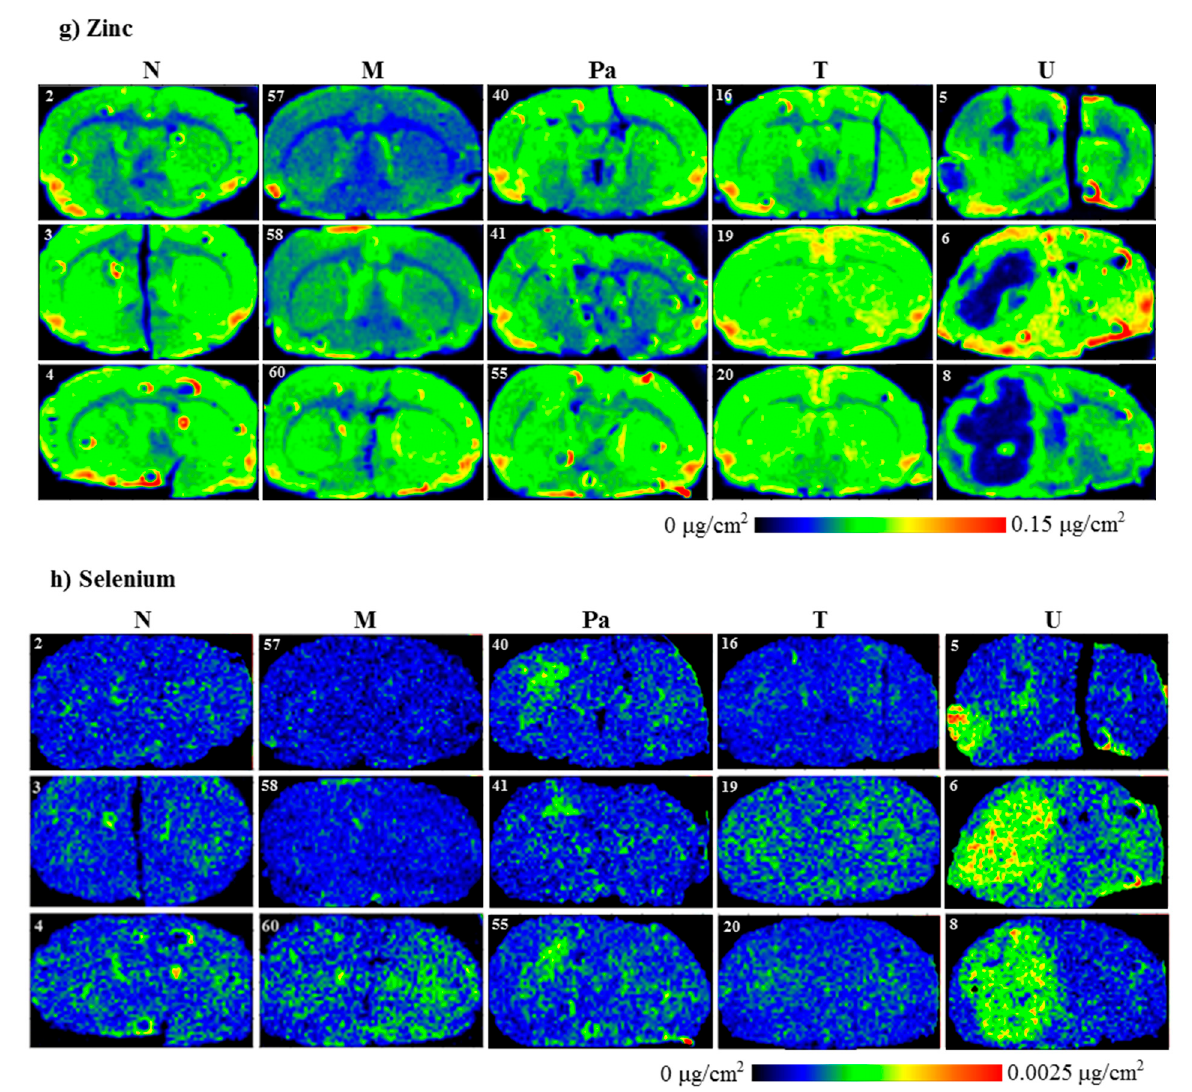
Figure 3. Topographic elemental maps of brain slices taken from the rats of all experimental groups for: ( a ) phosphorus, ( b ) sulfur, ( c ) potassium, ( d ) calcium, ( e ) iron, ( f ) copper, ( g ) zinc and ( h ) selenium. Color scales express areal densities of elements in µ g/cm 2 . In the case of Ca, large differences in areal densities were observed between groups N, M, Pa, T and group U. Two different scales were applied for better visualization of the distribution of this element.